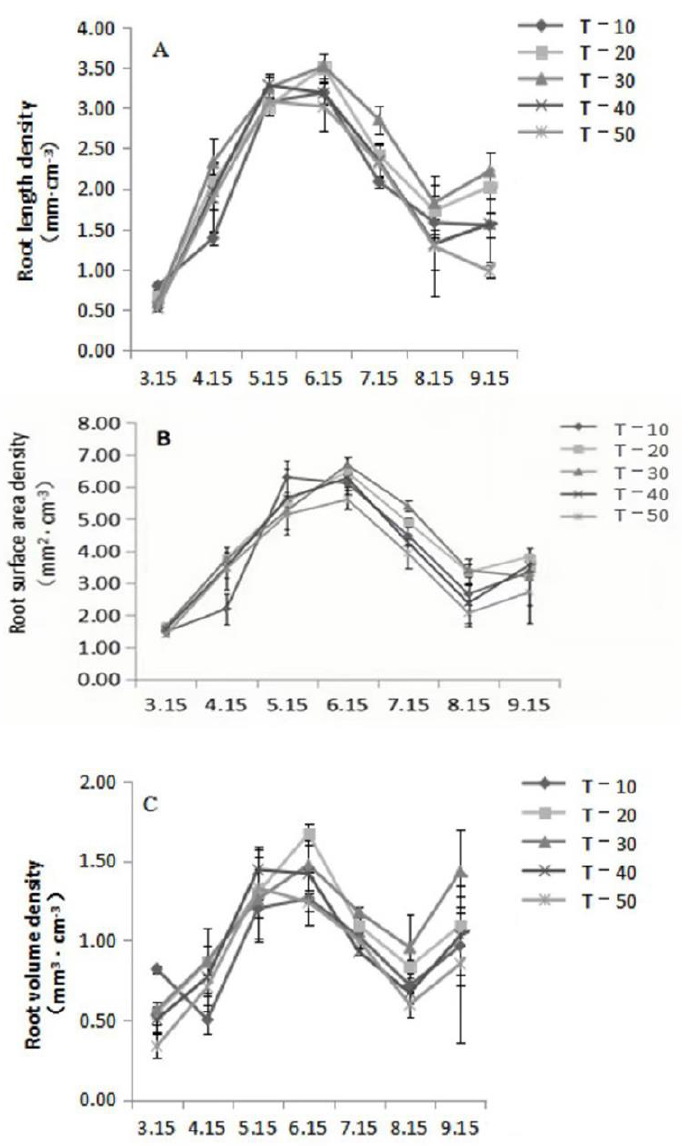
Figure 1. Effects of interstock length on root growth. ( A )—root length density; ( B )—root surface area density; ( C )—root volume density.